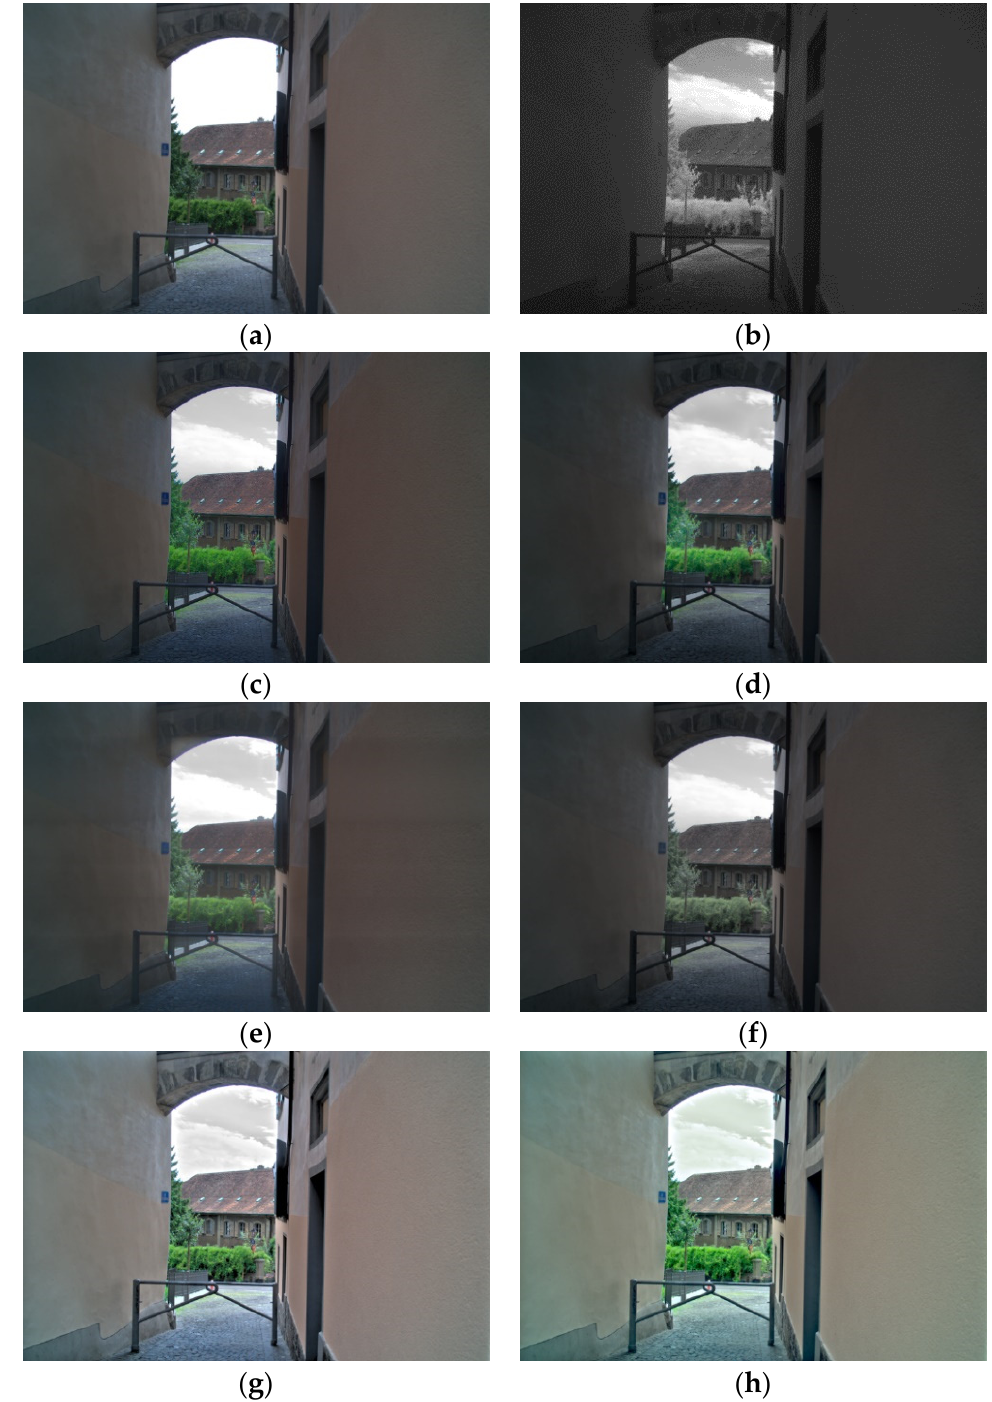
Figure 11. Input pair and result images: ( a ) visible image; ( b ) IR image; ( c ) Laplacian pyramid entropy fusion; ( d ) Laplacian pyramid PCA fusion; ( e ) low-rank fusion; ( f ) dense fusion; ( g ) proposed method (luminance channel fusion); and ( h ) proposed method (XYZ channel